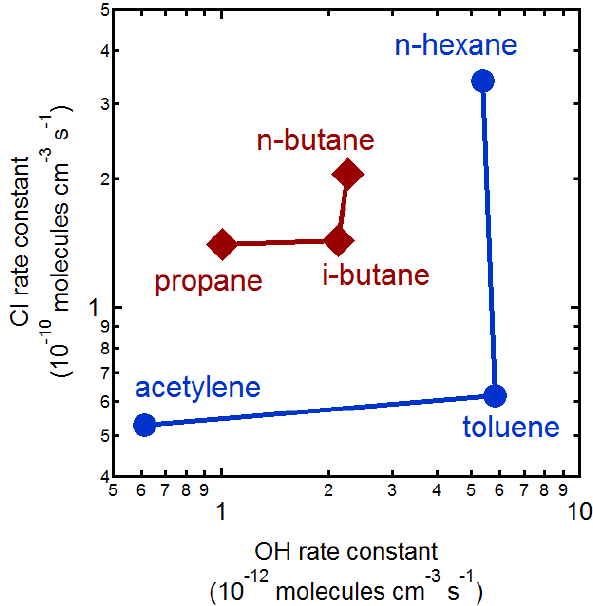
Fig. 1. Rate constants for reaction of Cl and OH with VOCs that are used to infer the influence of Cl oxidation. Rate constants are those used in the model, under conditions described in Table